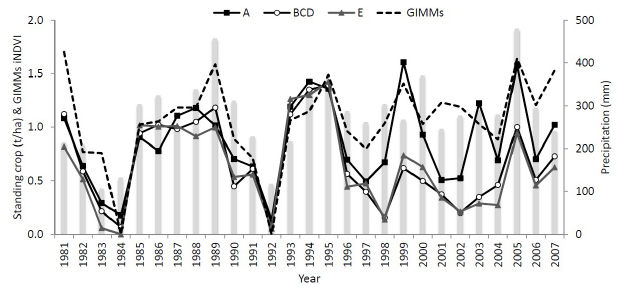
Figure 2. Light grey columns: Annual precipitation recorded at Widou Thiengoly test site. Values calculated as average from 2–6 gauges. Solid lines: ESSB measured for different grazing regimes, A: excluded from grazing, BCD: controlled grazing, E: communal grazing. Dashed line: GIMMS3g small integrated NDVI (absolute thresholds applied).